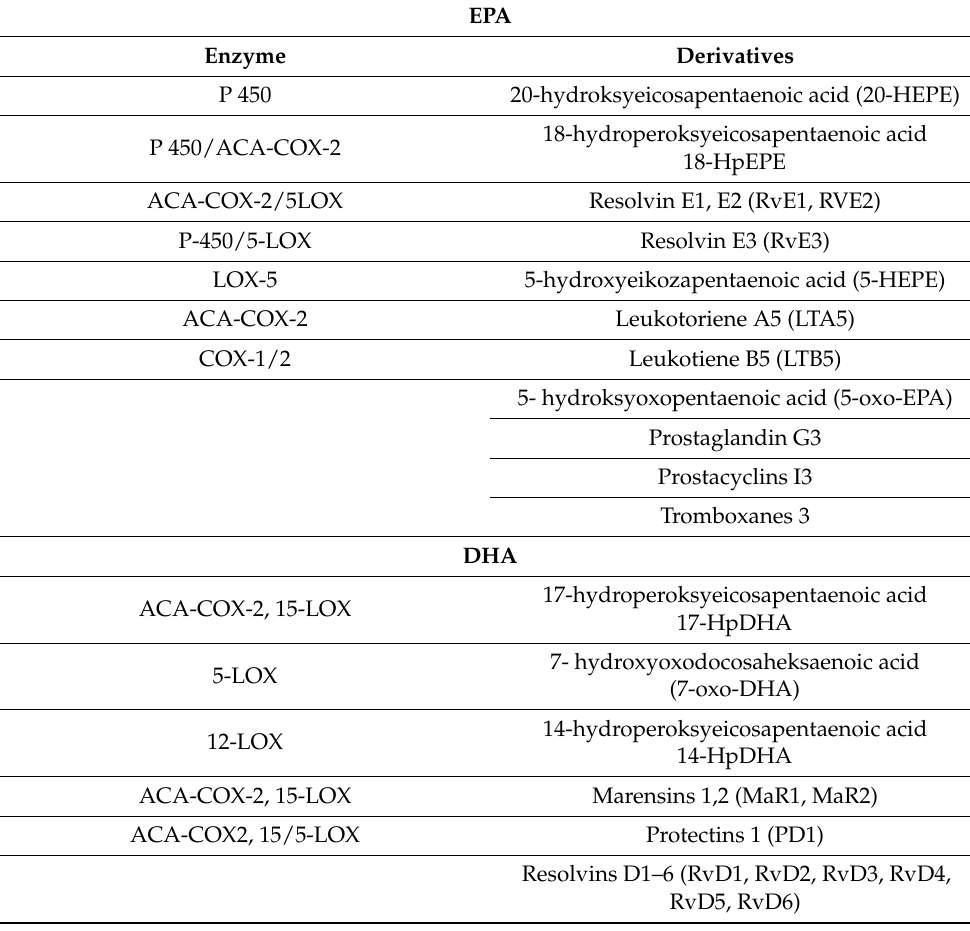
Table 1. Enzymatic deratives of EPA, DHA and